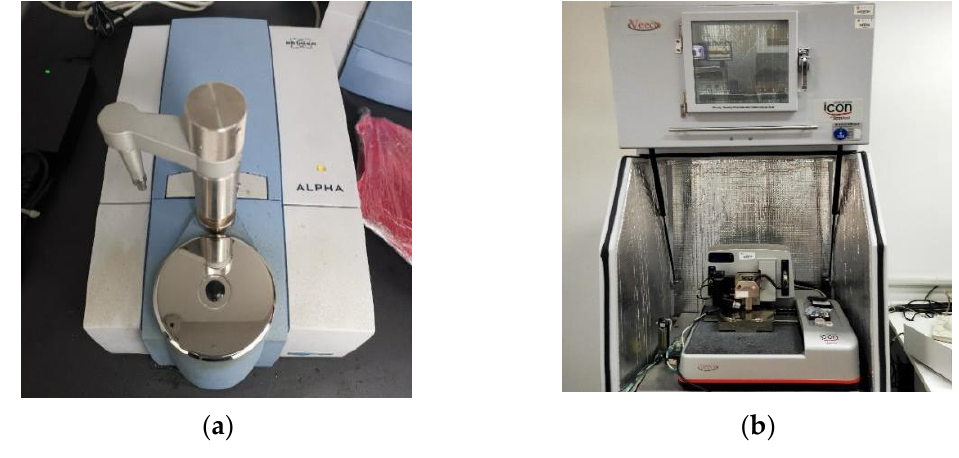
Figure 3. Microscopic analysis equipment: ( a ) FTIR-ATR; ( b ) AFM.